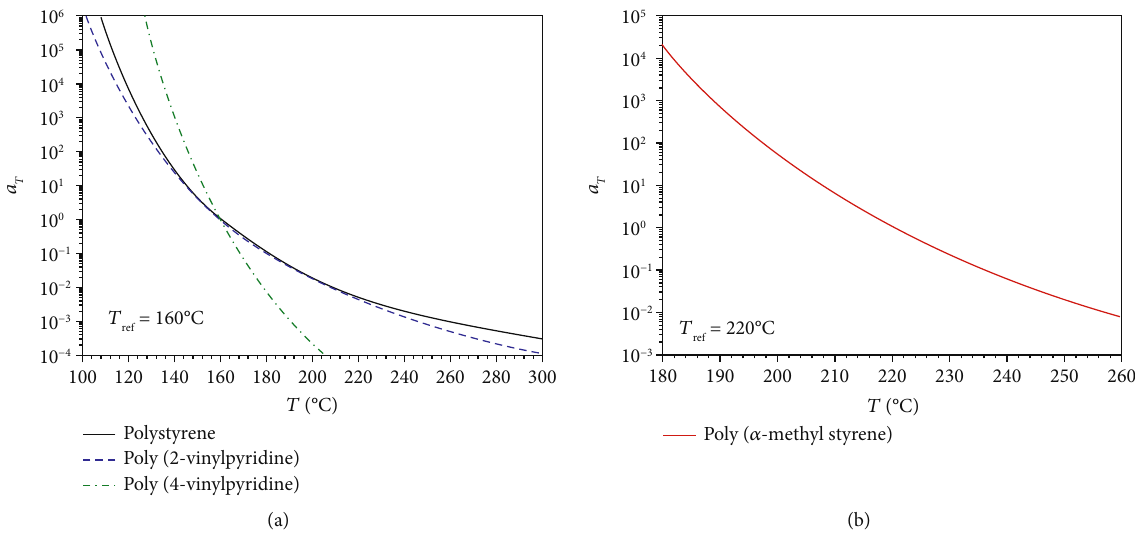
Figure 13: Shift factor calculated using the WLF equation for the four polymers of this study. The reference temperature T and (b) 220 ° C. Table 5: Parameters of the WLF equation at the reference temperature T Polymer ~ c